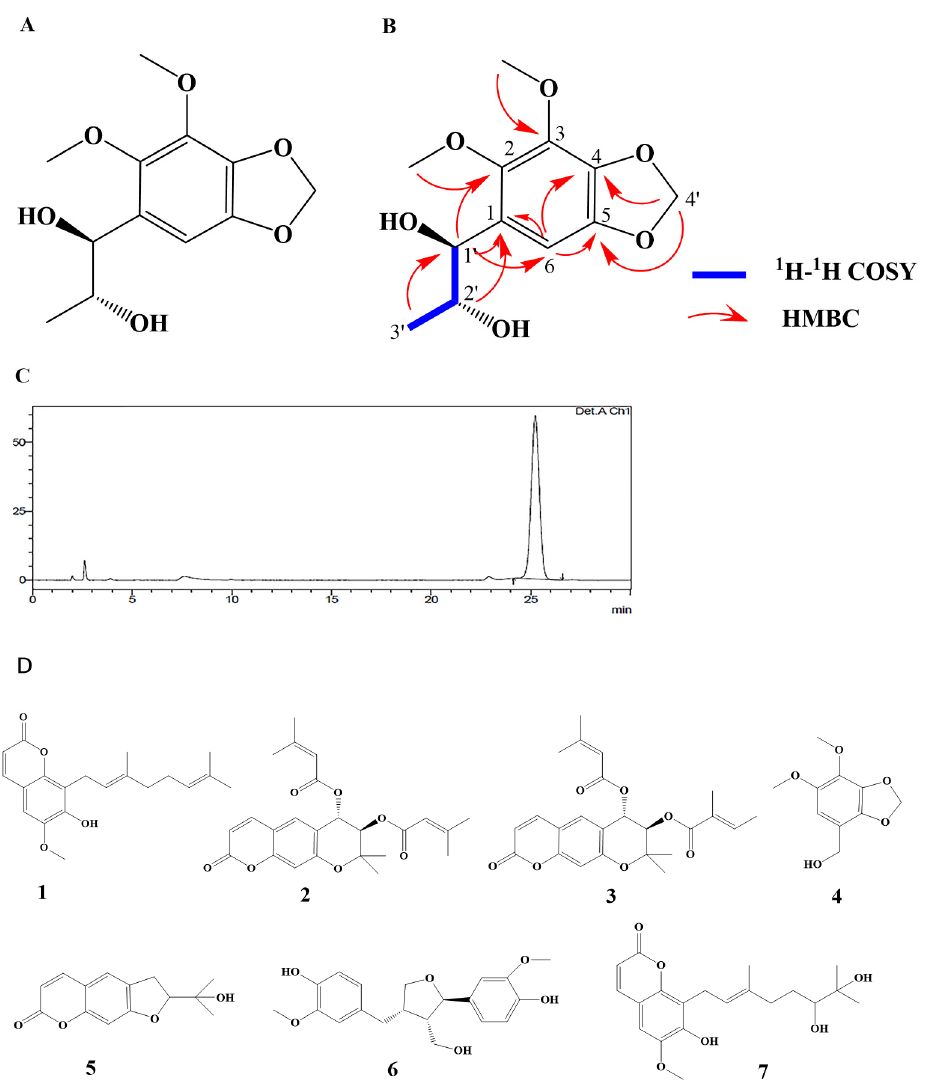
Figure 2. ( A ) Chemical structure, ( B ) key homonuclear chemical shift correlation spectroscopy ( 1 H − 1 H COSY ) , and heteronuclear multiple bond correlation ( HMBC ) correlations. ( C ) HPLC chromatogram analysis of isodillapiolglycol (IDG). ( D ) Chemical structures of compounds 1 – 7 .